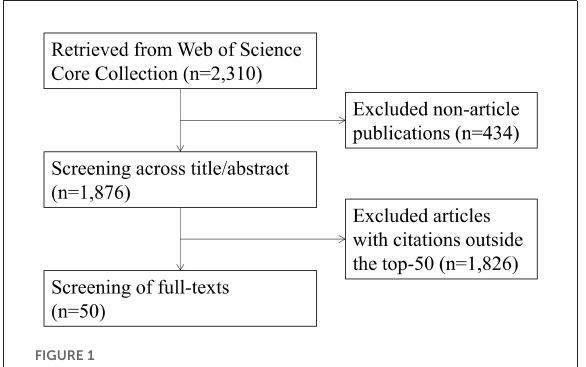
FIGURE1 Flow chart of literature